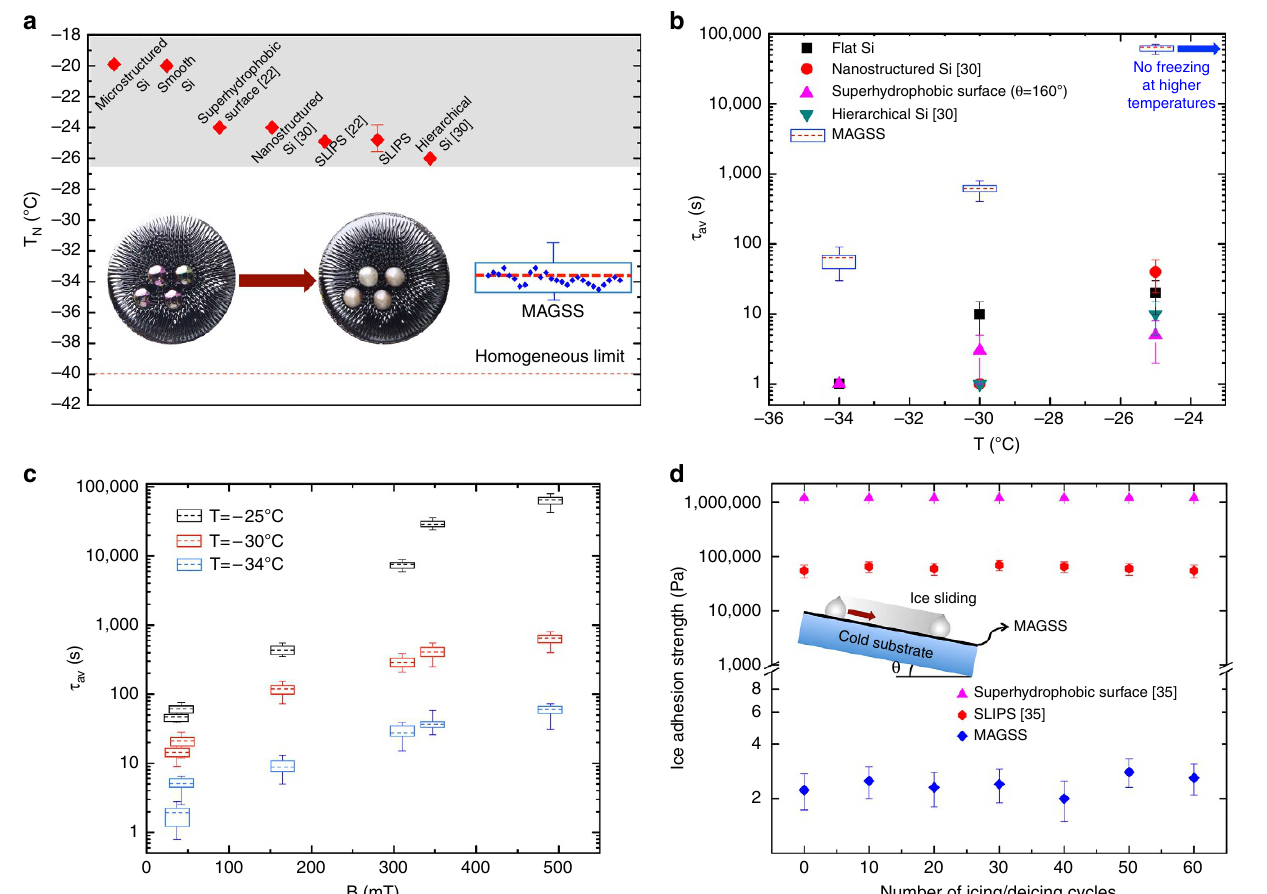
Figure 2 | Exceptional icephobicity of MAGSS. Exceptional icephobicity of MAGSS is studied with three figures of merit. ( a ) Median nucleation temperature of MAGSS is compared with other state-of-the-art icephobic surfaces. We achieved a T N value of (cid:2) 34 ± 1 (cid:2) C for MAGSS. This value is the median of 35 measurements, which are included as the error bar (see Supplementary Note 5). The formation of a low-energy magnetic liquid–liquid interface limits the ice formation to extremely low temperatures close to homogeneous nucleation limit. The inset shows the structure of MAGSS before and after ice formation. Note that there is essentially no change in the structure of MAGSS after the freezing process. ( b ) Ice nucleation delay time for MAGSS is compared with other icephobic surfaces. MAGSS outperforms the other surfaces over all temperature ranges and the ice nucleation delay time is 2–3 orders of magnitude higher than state-of-the-art icephobic surfaces. Note that at temperatures higher than (cid:2) 25 (cid:2) C, we could not detect any ice nucleation on the MAGSS surfaces after 27h. ( c ) At lower magnetic fields, t av is proportional to the imposed magnetic field, but at higher magnetic fields and complete exclusion of solid–water interface, t av remains constant (see Supplementary Note 5). ( d ) The ice adhesion strength on MAGSS is five orders of magnitude lower than the other icephobic surfaces. The exceptional ice adhesion strength is achieved through magnetic slippery liquid–liquid interface. The number of measurements for each figure of merit and their statistics are provided in Supplementary Note 5. The range of measured data are shown as error